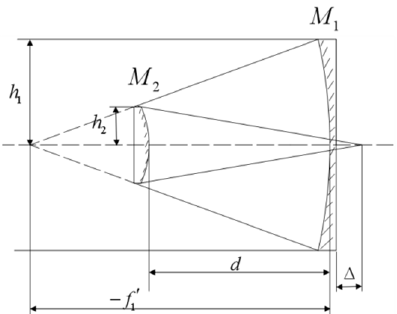
Figure 3. The configuration of the two-mirror system.